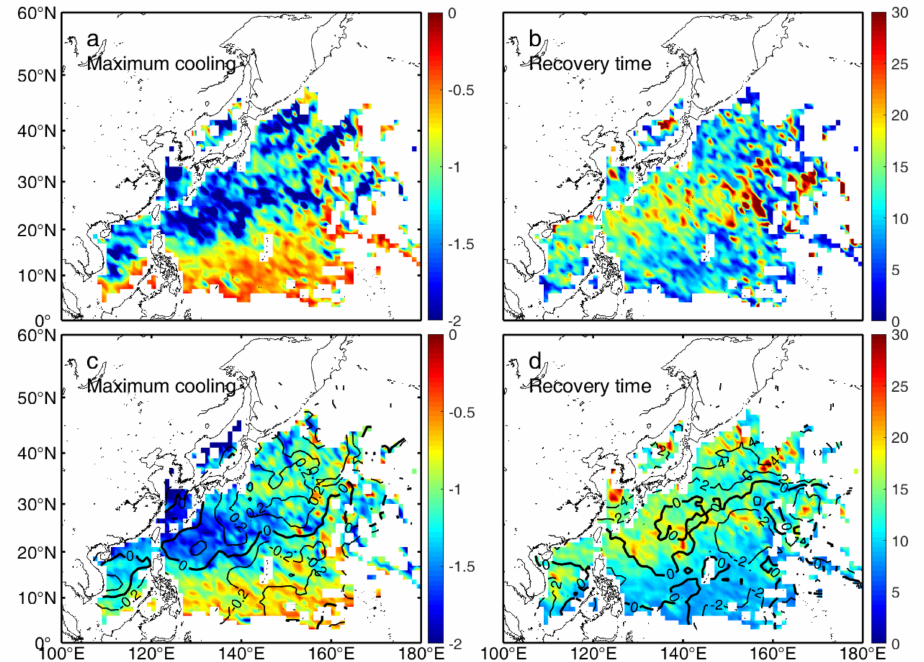
Figure 9. Spatial distribution of ( a ) observed maximum cooling (unit: ◦ C), ( b ) observed recovery time (unit: day), and ( c ) regressed maximum cooling (unit: ◦ C) calculated from the regression function on MLD, UTTG, TC intensity, and TC translation speeds and ( d ) regressed recovery time (unit: day) calculated from the regression function on maximum cooling. Contours in ( c , d ) represent the difference between observation and regressed values (regressed value minus observation) on a 3 ◦ × 3 ◦ spatial grid. All panels are observed/computed on a 1 ◦ × 1 ◦ spatial